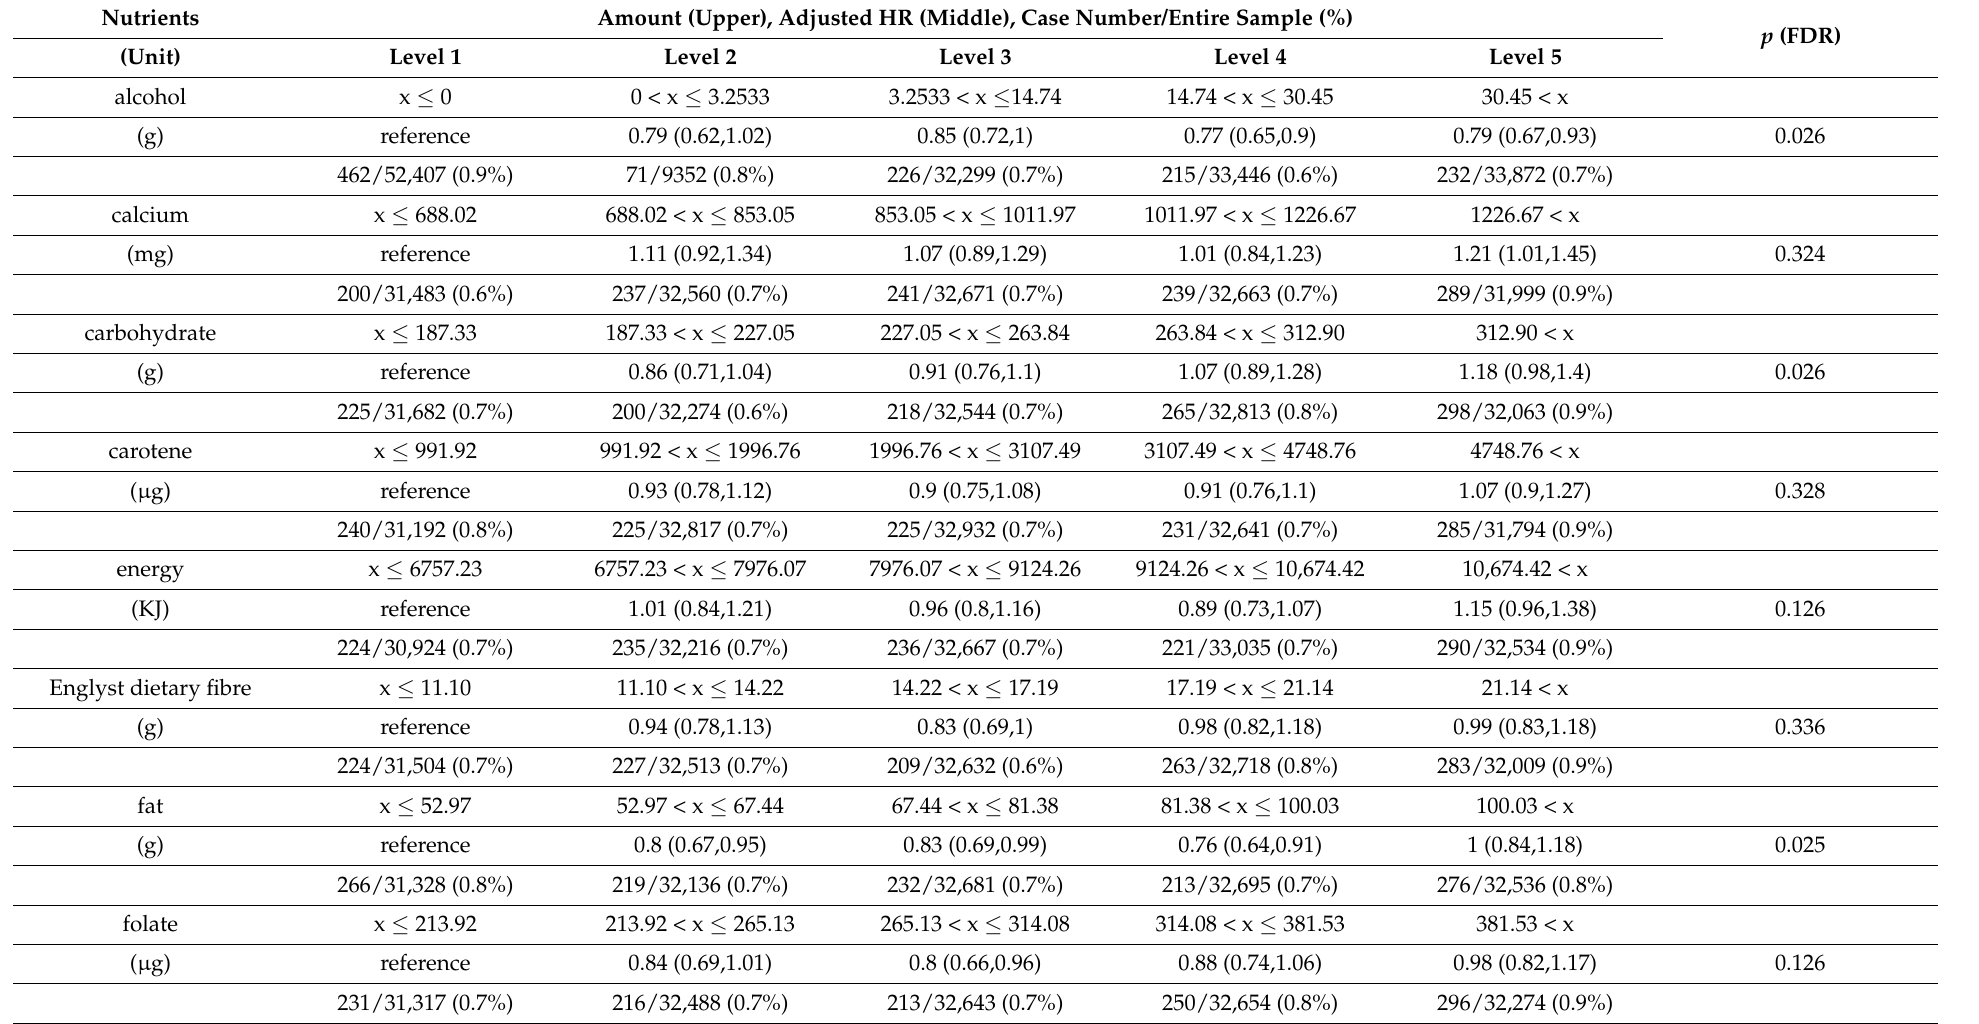
Table 2. Nutrient intake level (amount, adjusted HR, and case ratio) for each group and uncorrected and corrected p values of overall group